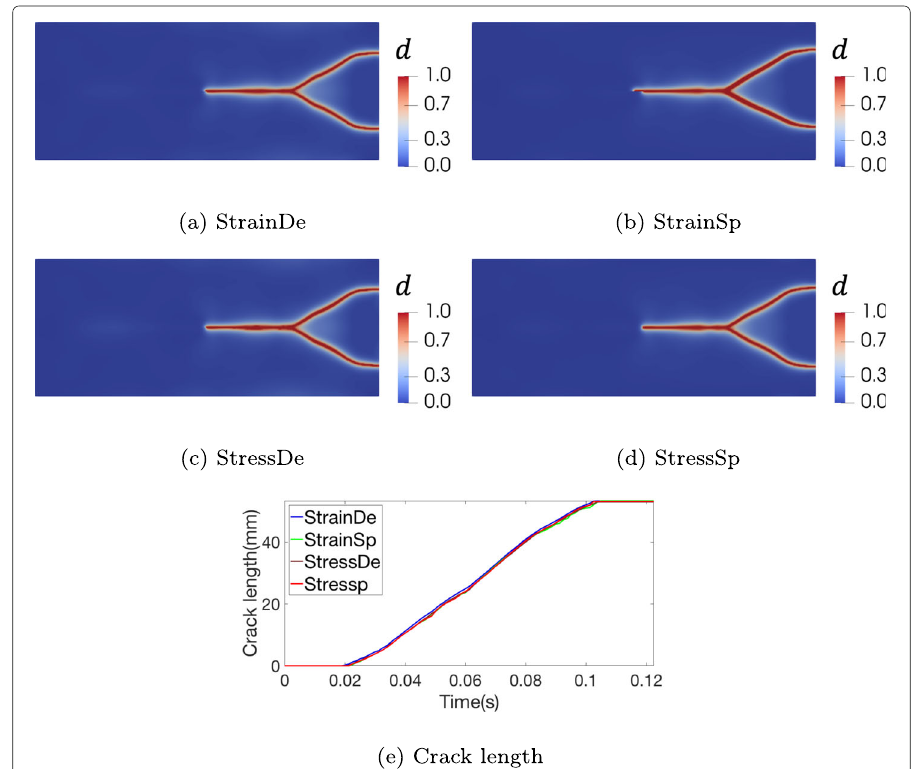
Fig. 17 Fracture results from the dynamic shear fracture simulations: ( a ) – ( d ) final crack paths for the strain deviatoric, strain spectral, stress deviatoric decomposition, and stress spectral methods, respectively; ( e ) the crack length evolution for the four